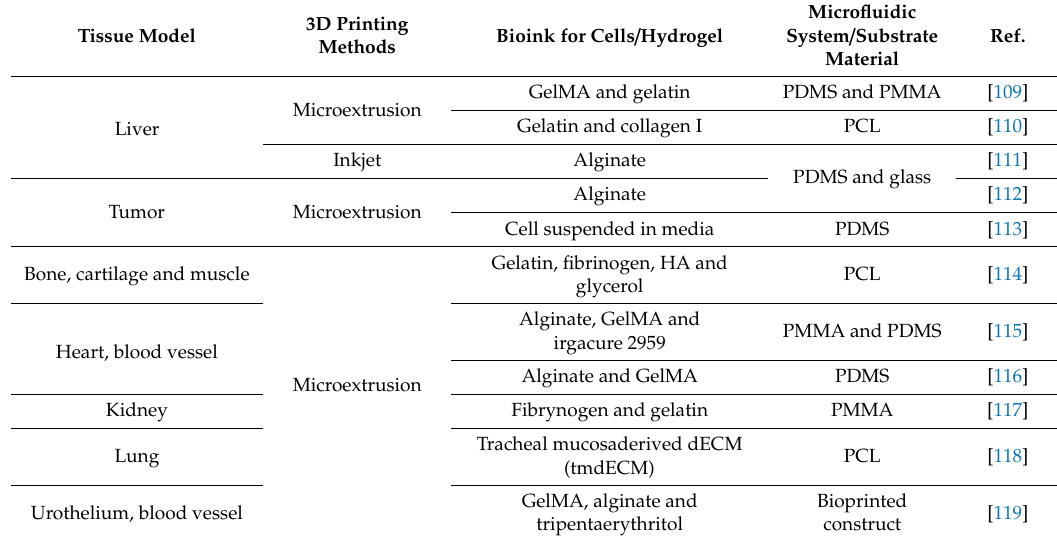
Table 2. Examples of a combination of bioprinting and microfluidics. dECM: decellularization,